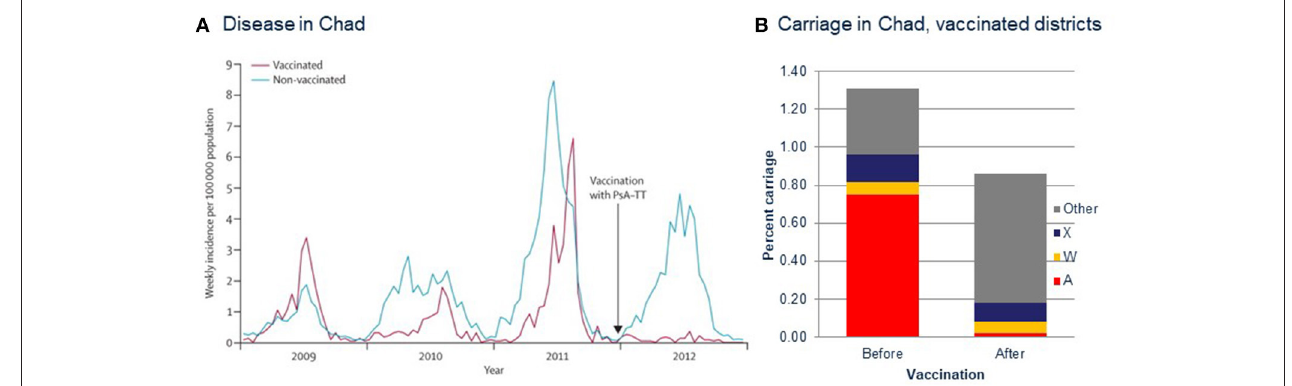
FIGURE 3 | Measuring vaccine efficacy in the meningitis belt during PsA-TT (MenAfriVac) introduction in Chad using genomic sequencing techniques. (A) Incidence of reported cases of meningitis in Chad, 2009–2012. Vaccination with PsA–TT was undertaken in patients aged 1–29 years at the end of 2011 (arrow). PsA–TT = serogroup A meningococcal polysaccharide–tetanus toxoid conjugate vaccine. (B) Carriage rates of meningococci of different serogroups before and after vaccination. (A) Reproduced from Daugla et al. (68) without modification under CC